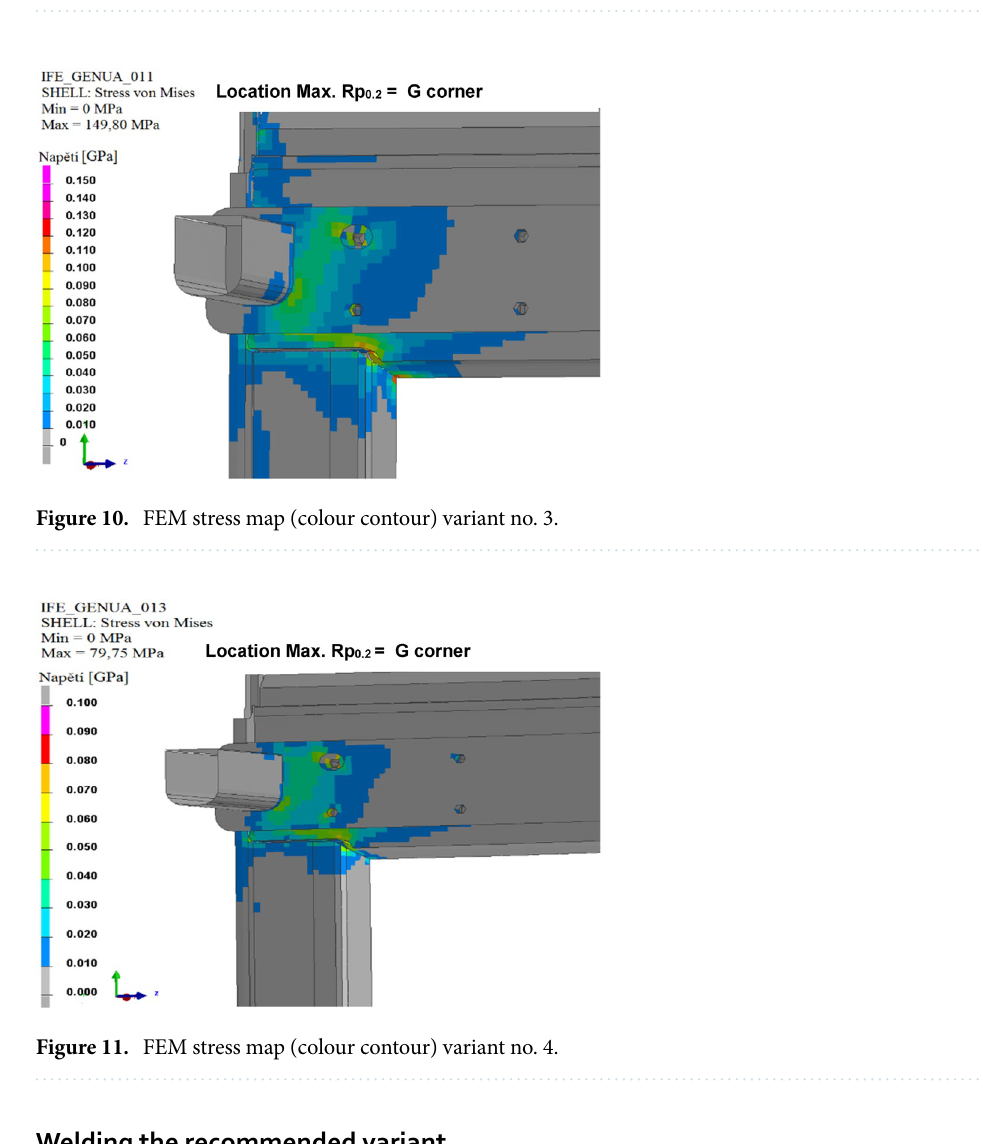
Figure 9. FEM stress map (colour contour) variant no. 2.